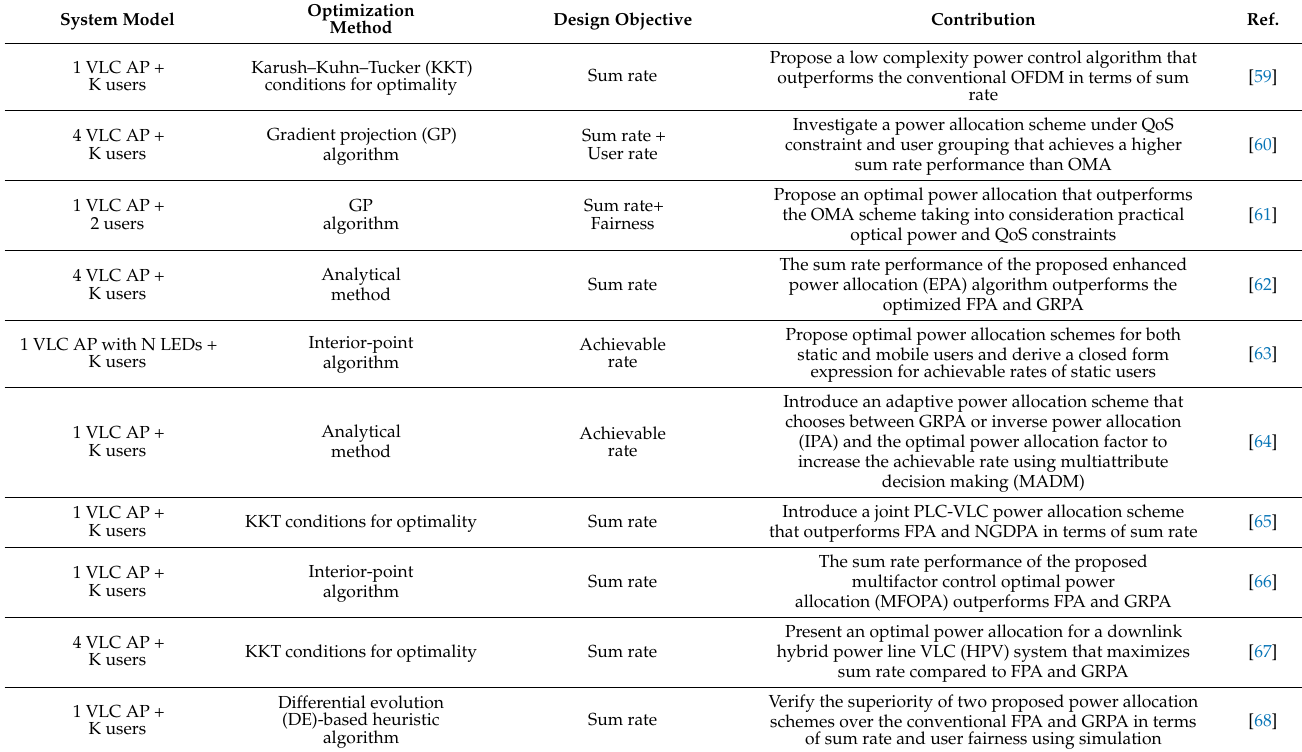
Table 2. A summary of power allocation optimization in PD-NOMA downlink VLC